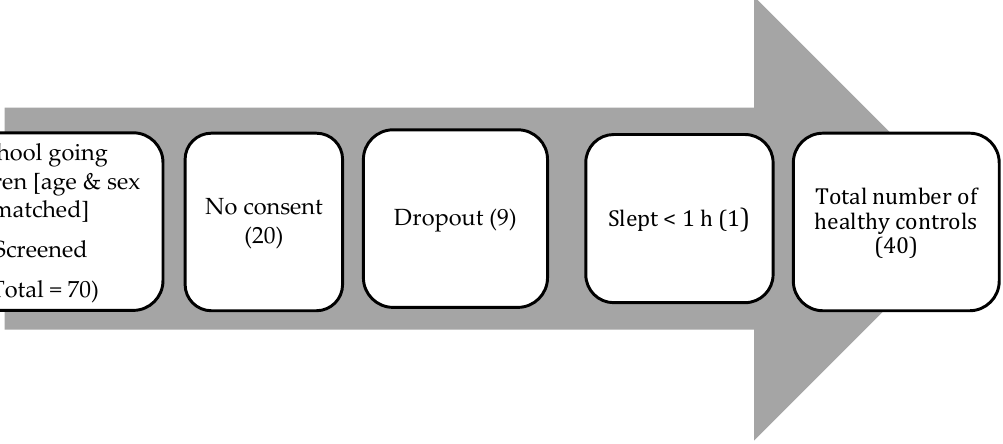
Figure 2. Recruitment process for participants in the control group.